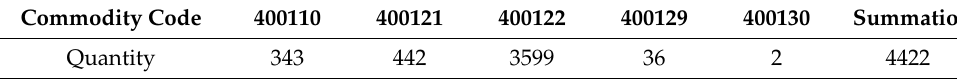
Table 2. The quantity of records corresponding to different